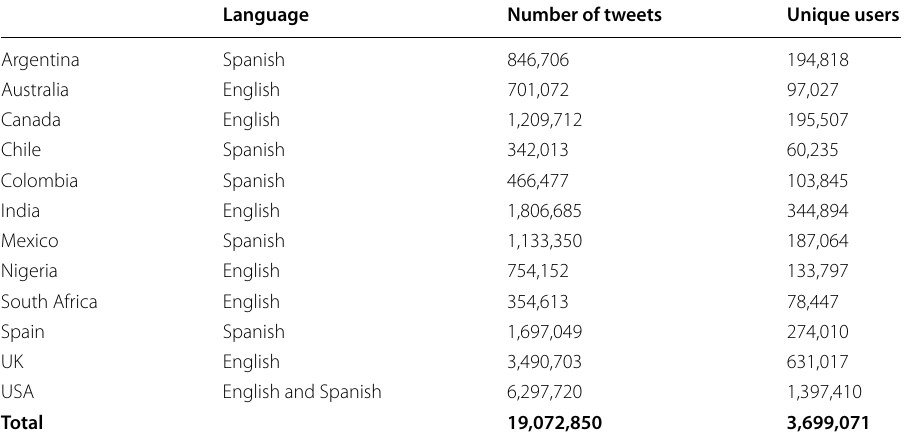
Table 1 Per-country summary of the Covid-19-related Twitter dataset constructed from the repository maintained by Banda et al.